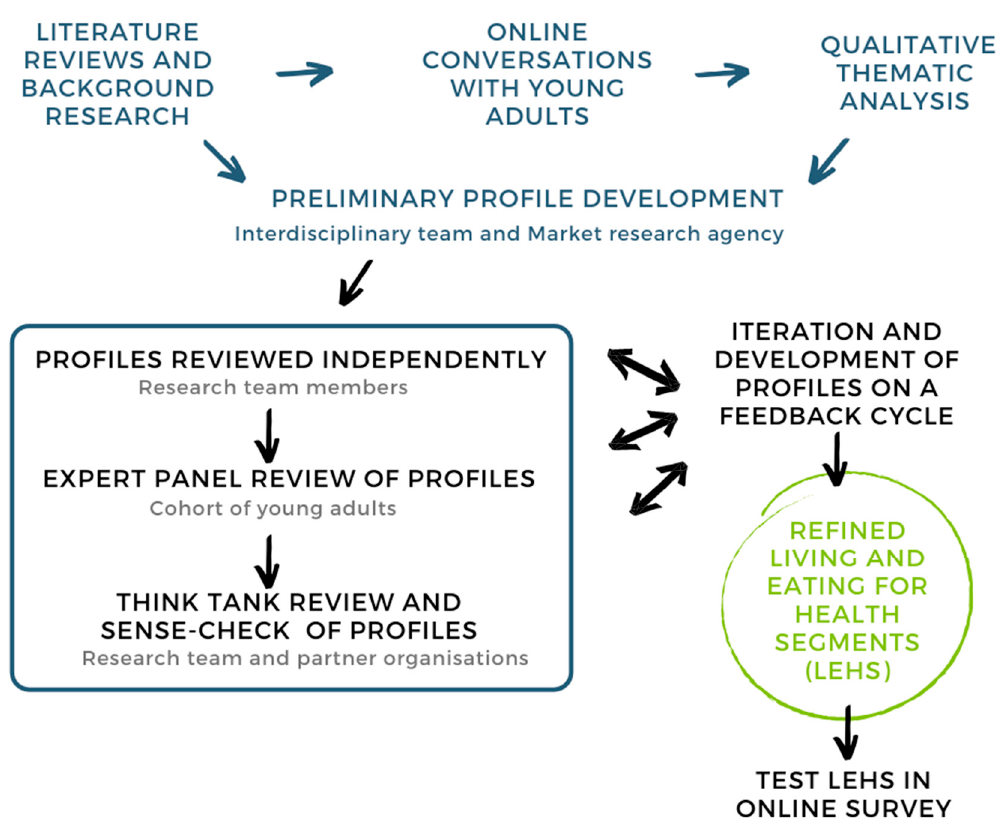
Figure 1. Mixed-methods approach to instrument development for Living and Eating for Health Segments. Table 1. Types of validity and formative research stages in LEHS profile development.